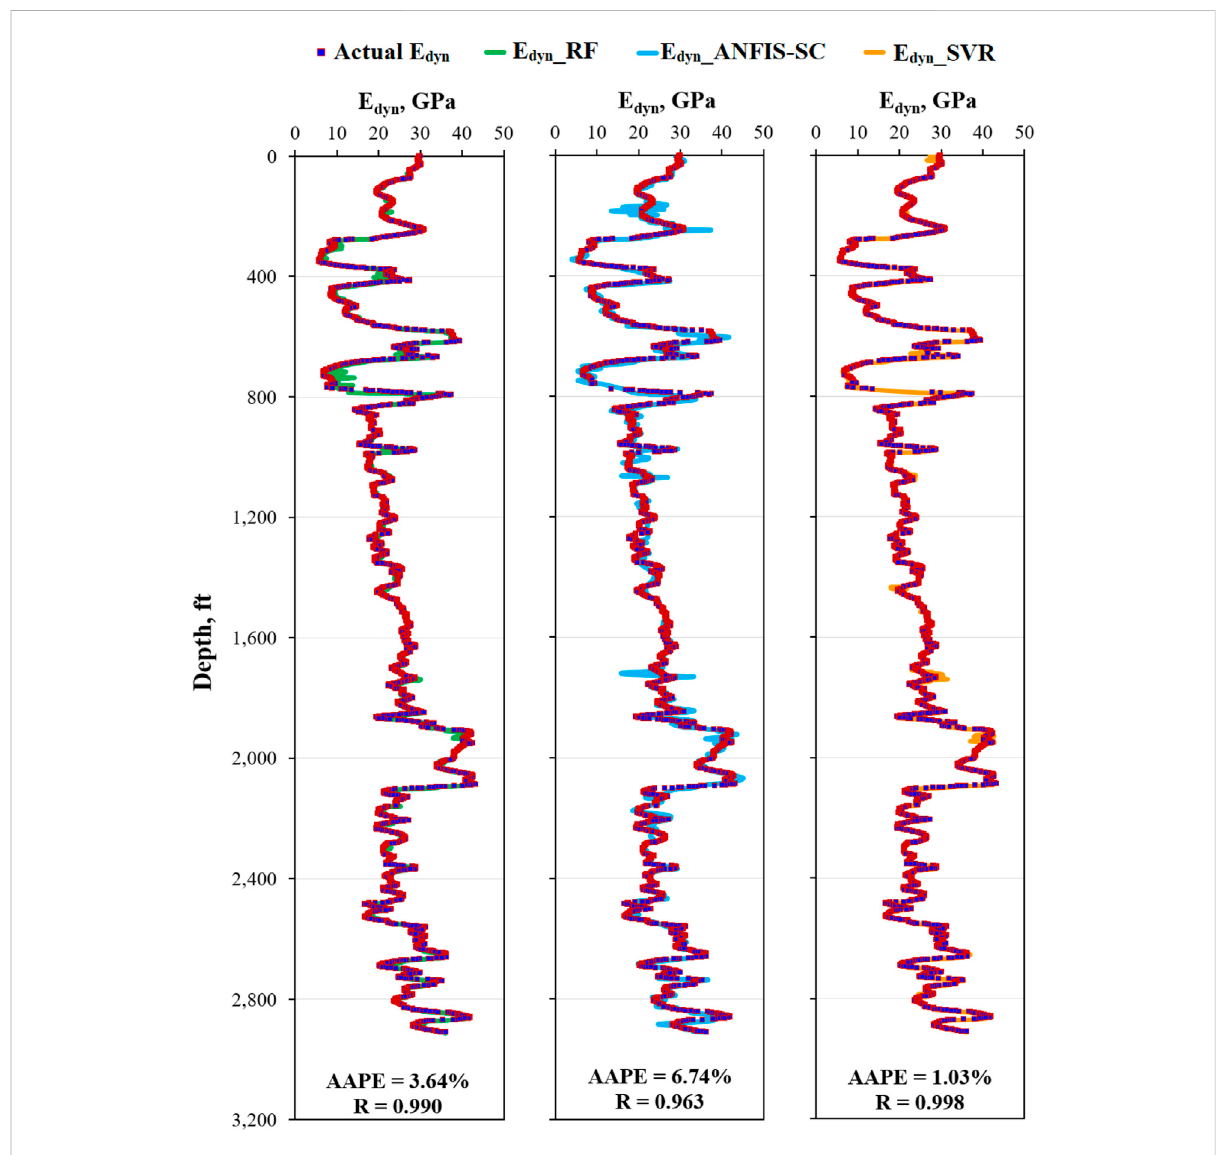
FIGURE 7 Actual and assessed E dyn by the optimized RF, ANFIS-SC, and SVR models, for the 2912 validation data points of Well-C.